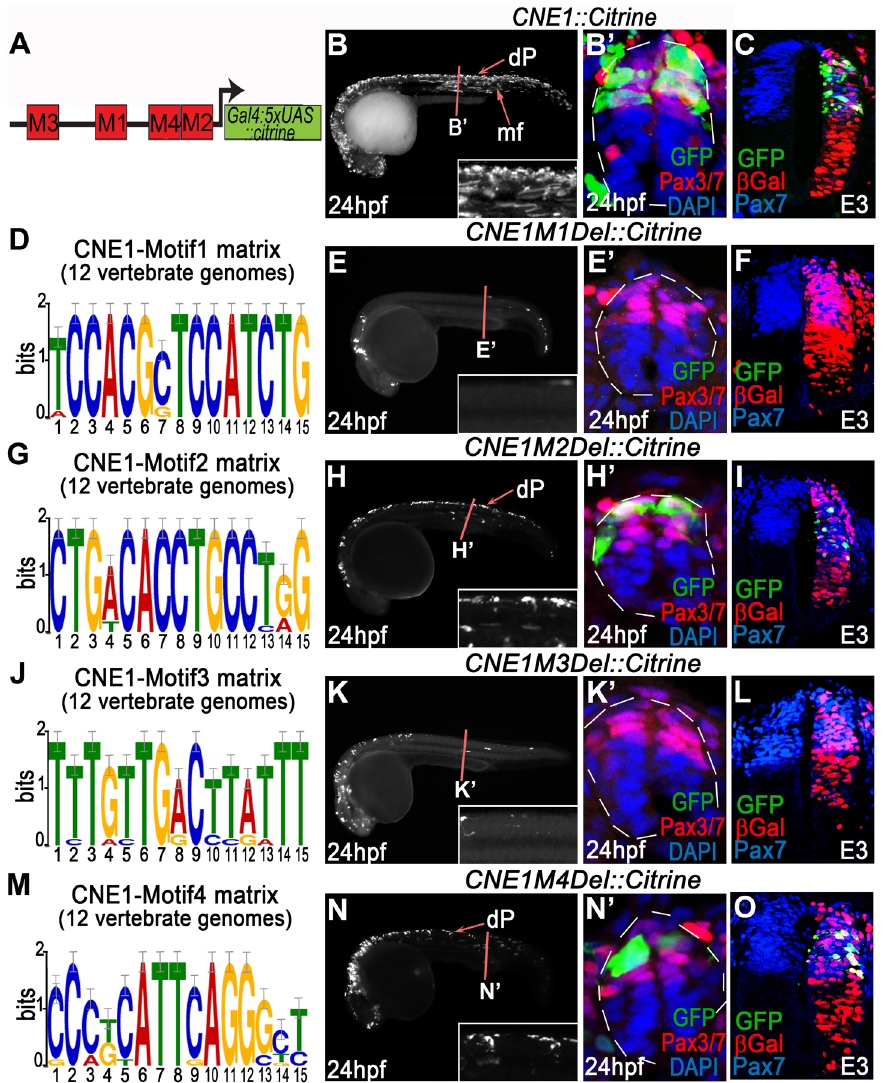
Figure 3. Functional dissection of CNE1 enhancer activity. (A) Schematic outlining the organisation of motifs within CNE1. (B, B 9 ) CNE1 transient transgenic zebrafish embryos recapitulate pax3a expression across the AP axis of the CNS, including the spinal cord (n=66/67). (C) Zebrafish CNE1 sequence specifically drives transgene expression in the Pax3/7 domain of the chick spinal cord, despite widespread transfection of LacZ across the DV axis of the tissue (n=10/12). (D) Matrix representing the degree of Motif1 conservation across 12 vertebrate genomes. (E, E 9 ) Deletion of Motif1 results in a complete loss of CNE1 activity in zebrafish spinal cord at trunk level (n=0/22, p , 0.0001), however the enhancer remains active in the anterior CNS (n=22/22) and the most posterior region of the spinal cord (n=8/22). (F) Loss of Motif1 greatly reduces CNE1 activity in the chick neural tube (n=1/8, p=0.0019). Motif2 (G), is not required for CNE1 activity in the zebrafish (H, H 9 ) (n=37/38) or chick (I) (n=4/6) spinal cord. Loss of Motif 3 (J) reduces CNE1 mediated transcription across the AP axis of the zebrafish CNS (K, K 9 ) (n=0/26, p , 0.0001) and precludes activity in the chick spinal cord (L) (n=0/5, p=0.003). Deletion of Motif4 (M) does not significantly alter the activity of CNE1 in zebrafish (N, N 9 ) (n=20) or chick (O) (n=4/